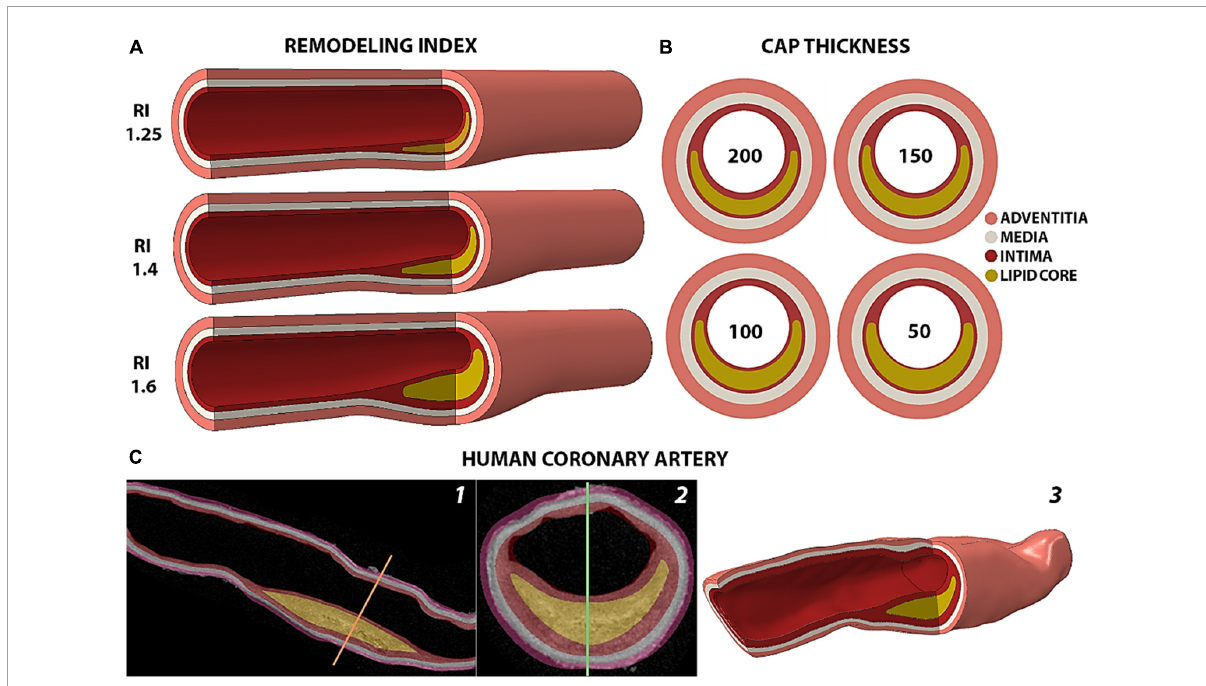
FIGURE1 Representation of the arterial models analyzed. (A) Isometric view of the idealized geometries of human coronary arteries with different remodeling indices and a 200 µ m-thick fibrous cap. (B) Cross section of fibroatheromas with different cap thicknesses of 200, 150, 100 and 50 µ m for the case of RI = 1.25. (C) Rendering of the human coronary artery from 2D HR- µ CT images in sagittal (1) and coronal (2) views to the 3D geometry reconstruction